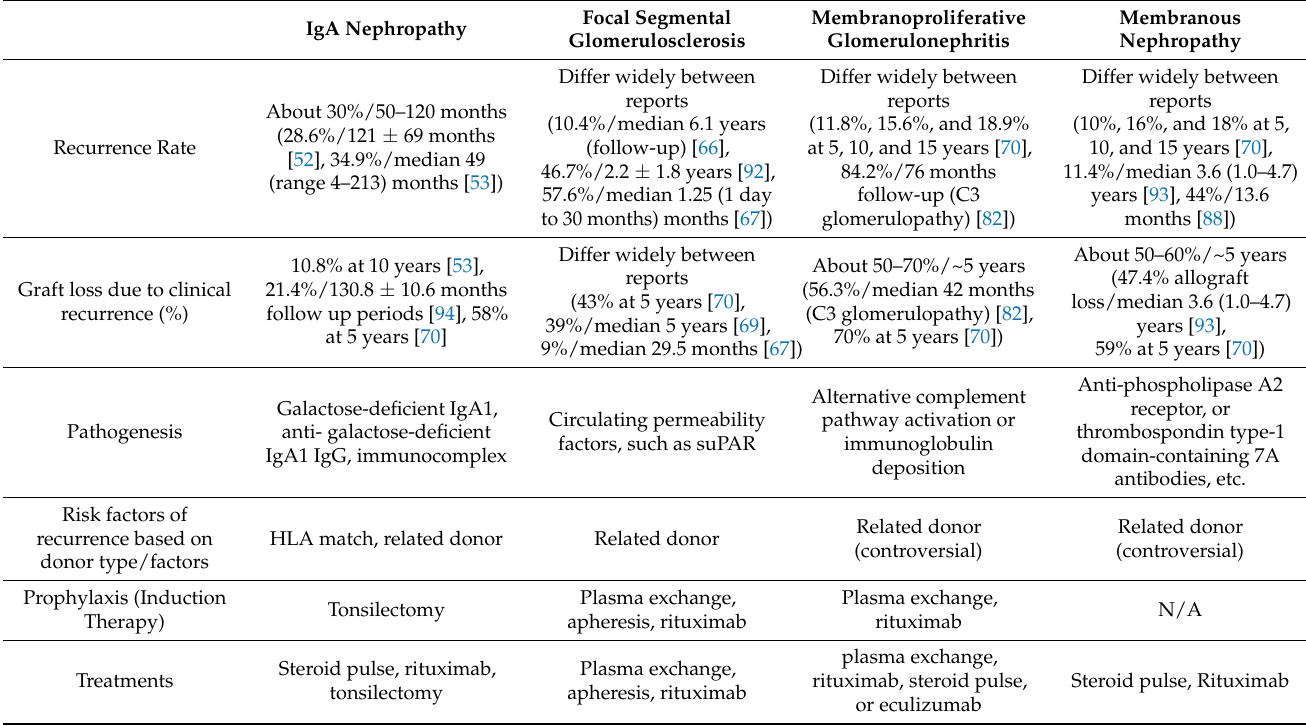
Table 2. Overall recurrence rate, other characteristics, available prophylaxis, and treatments in glomerulonephritis after kidney